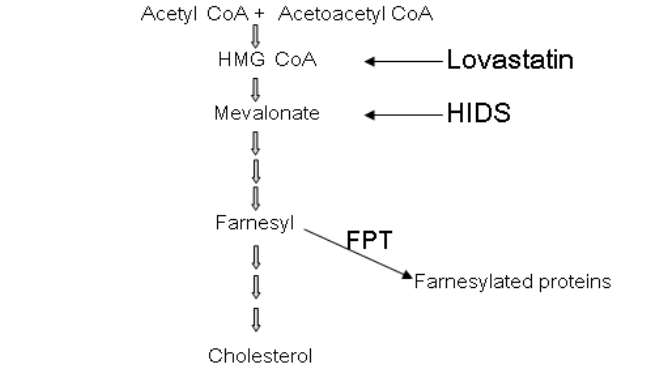
FIGURE 1. Schematic overview of the isoprenoid pathway. In the isoprenoid pathway, cholesterol is made from acetyl CoA and acetoacetyl CoA in several metabolic steps. Next to cholesterol, farnesyl is produced that can be covalently attached to proteins by the enzyme farnesyl protein transferase (FPT). In HIDS, mevalonate kinase is deficient, leading to a decrease of farnesylated protein. A deficiency of farnesyl can also be induced by inhibiting the enzyme HMG-CoA reductase, for example, by